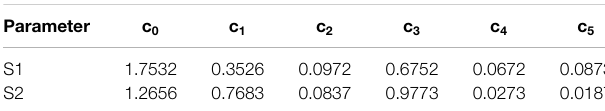
TABLE 4 | Fitting constant with operating cost as the objective function. Parameter